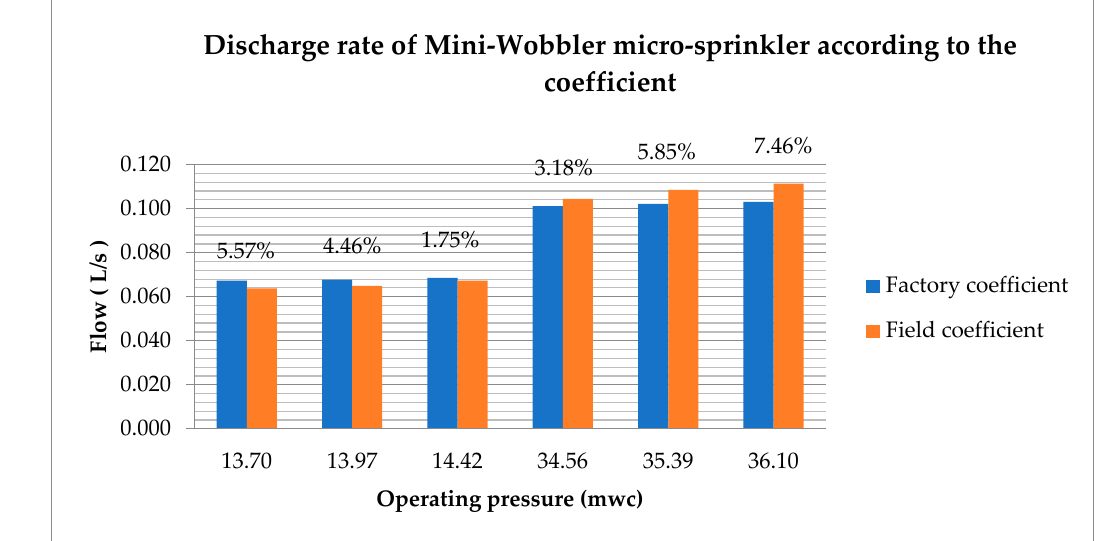
Figure 3. Comparison of micro-sprinkler discharge rates in Mini Wobbler.